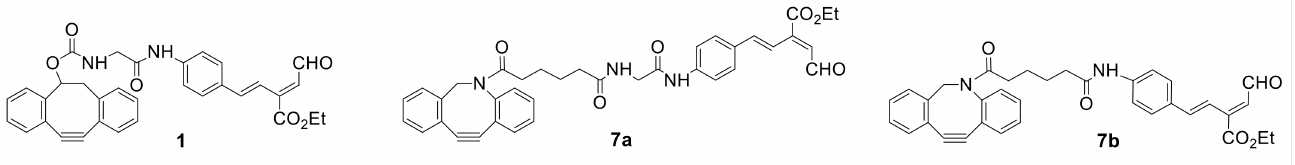
glycans immobilization on albumin via one-pot, double-click